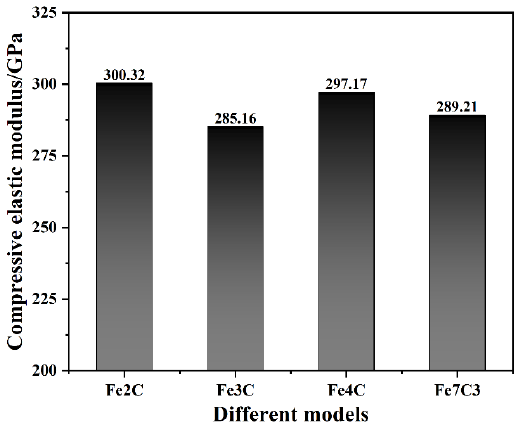
Figure 3. Compressive elastic modulus of all ferrite – carbide models.